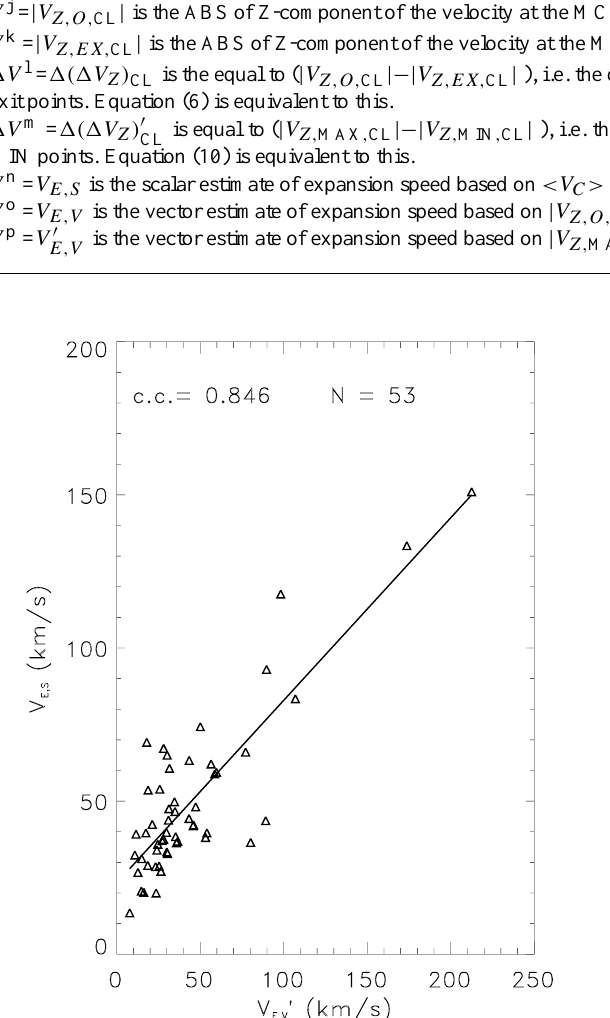
determined. The sources of error in R O are: (1) it is model- dependent with all of the model’s sources of errors and (2) a simple value for R O ( ≈ <(R MIN + R MAX ) /2 >) may not be adequate for a MC with an oval cross-section, as briefly dis- cussed in the beginning of Sect. 3. But as we will see